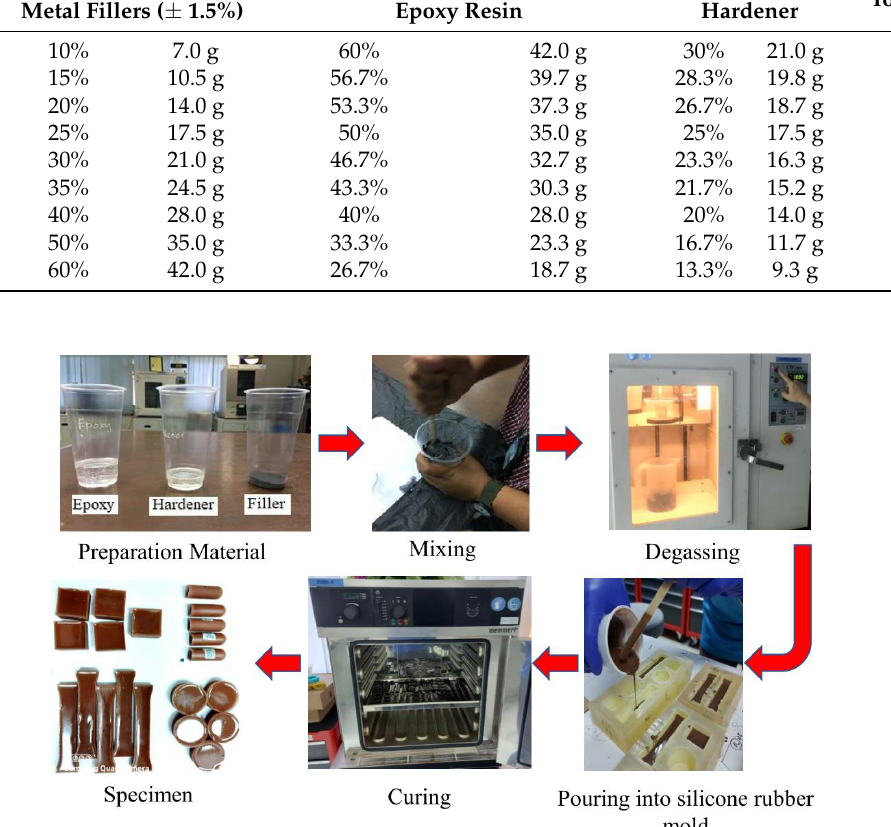
Figure 4. Specimen preparation.